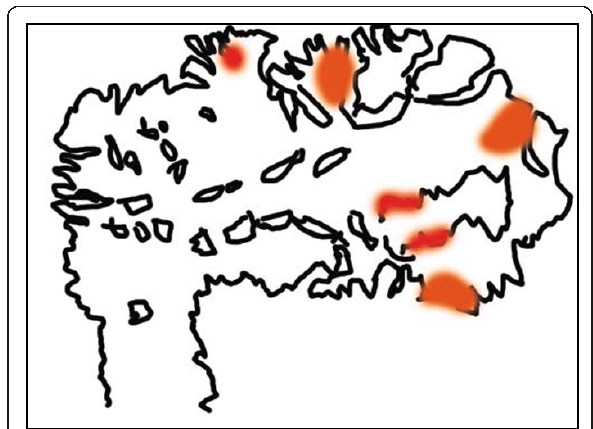
Figure 4 Schematic map of the adenocarcinoma arising in polyp . The present case has been diagnosed as CA19-9 producing gastric adenocarinoma arising in hyperplastic foveolar polyp. The small carcinoma components (red areas) arise in the surface of the polyp without apparent stromal invasion. Left lower side is a stalk of the adenocarcima in polyp.